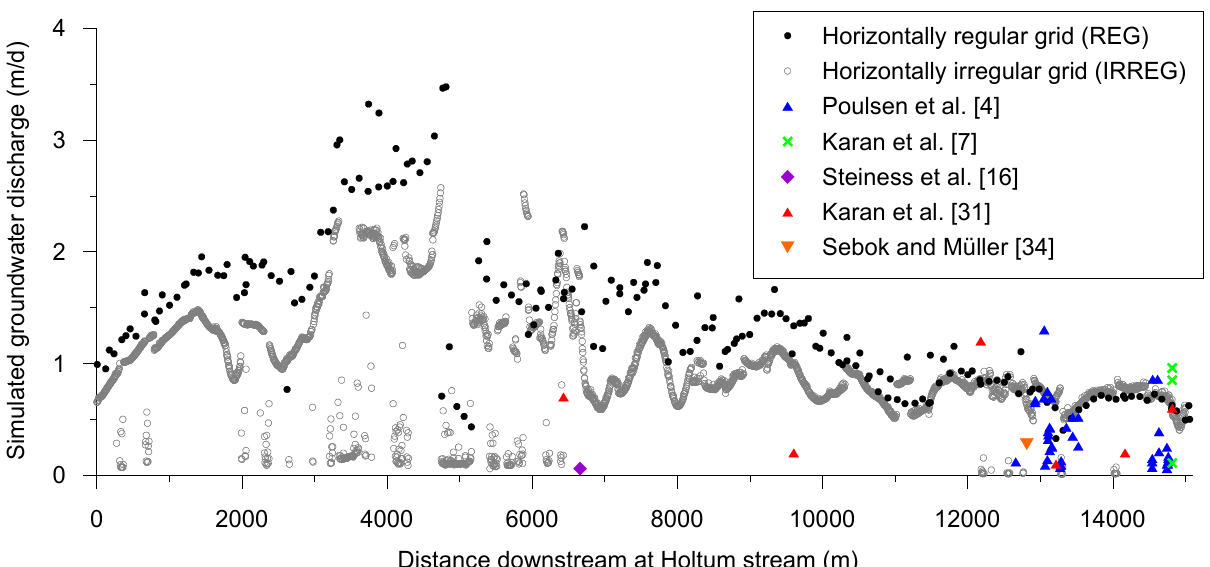
Figure 6. Calculated groundwater discharge along Holtum stream from the two model conceptualizations and previously estimated values [4,7,16,31,34].